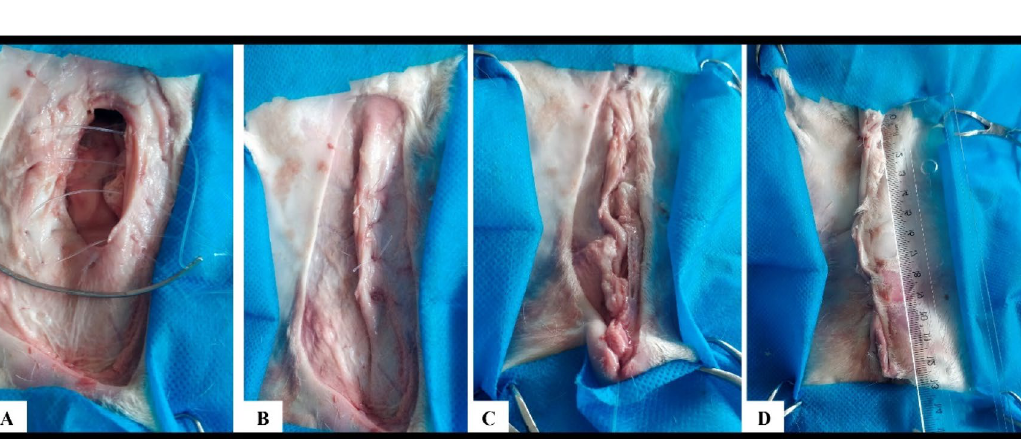
Figure 5. Abdominal tissue and skin closure of the abdominal cavity. ( A , B ) Show peritoneum/muscle dieresis with overlapping suture. ( C ) Shows reduction of subcutaneous dead space with muscle anchoring. ( D ) Shows skin closure with U